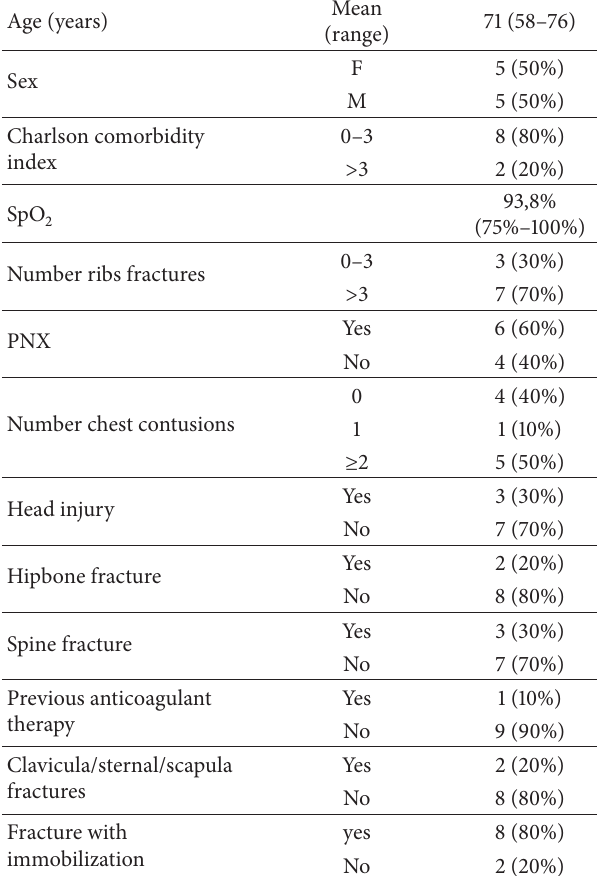
Table 3: Patients admitted to